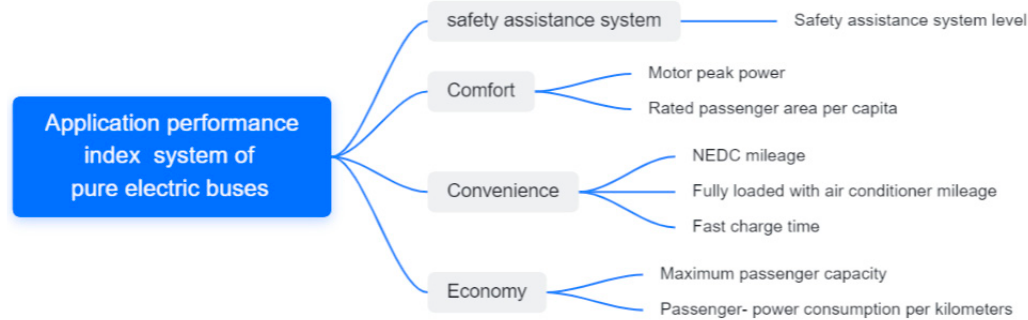
Figure 2. Application performance index system of pure electric buses.